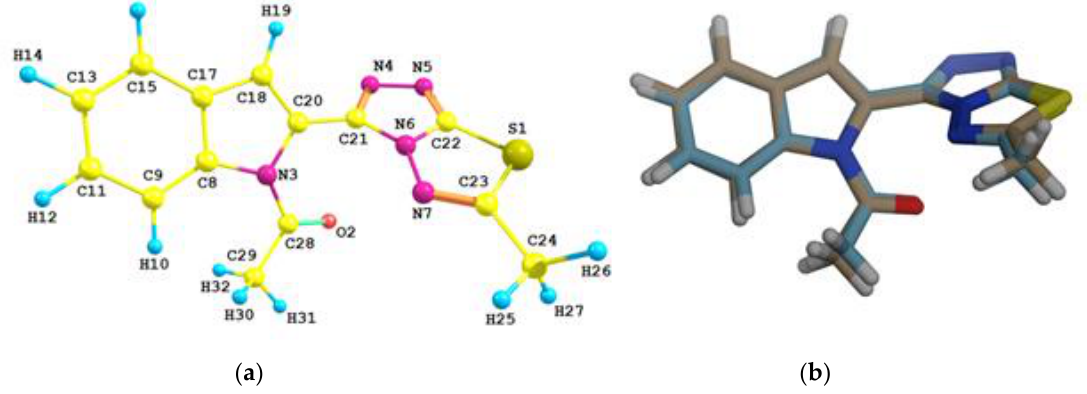
Figure 8. The optimized geometry ( a ) and overlay of the optimized geometry with experimental structures ( b ) for the target compound. Atom numbering refers to Table 3 and is different from that in Figure 3.